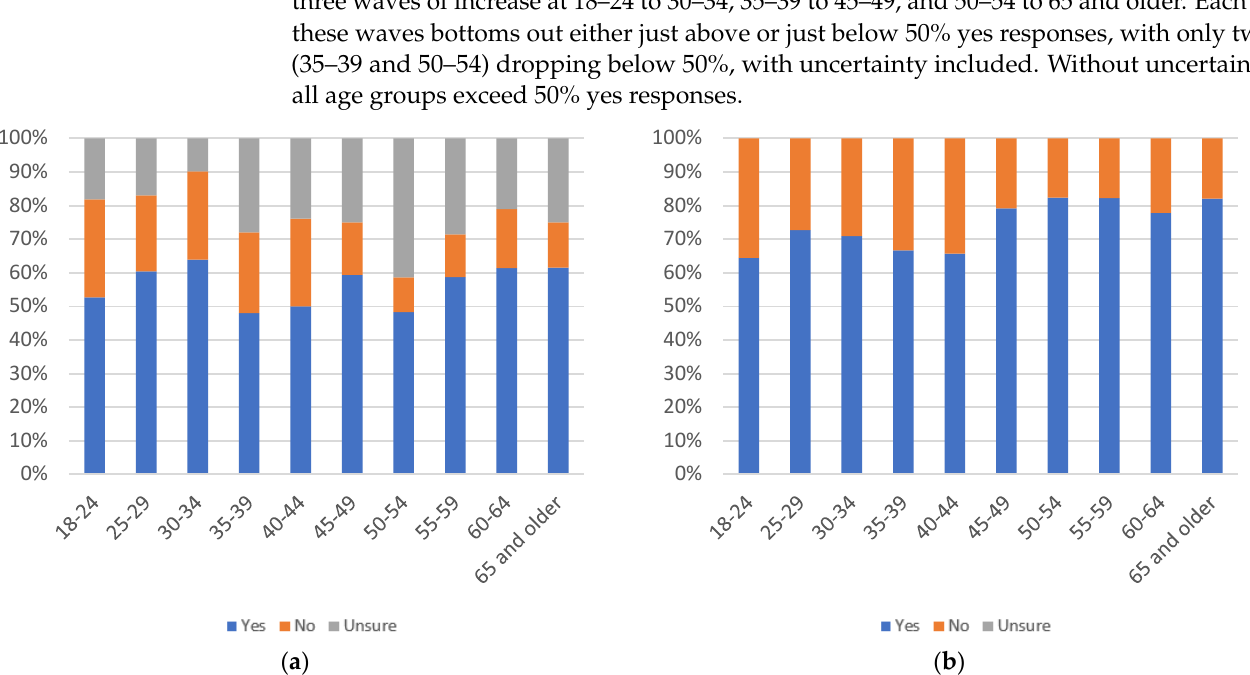
( b ) Figure 63. Label others’ use, by education level: ( a ) with uncertain respondents (left) and ( b ) without uncertain respondents (right).